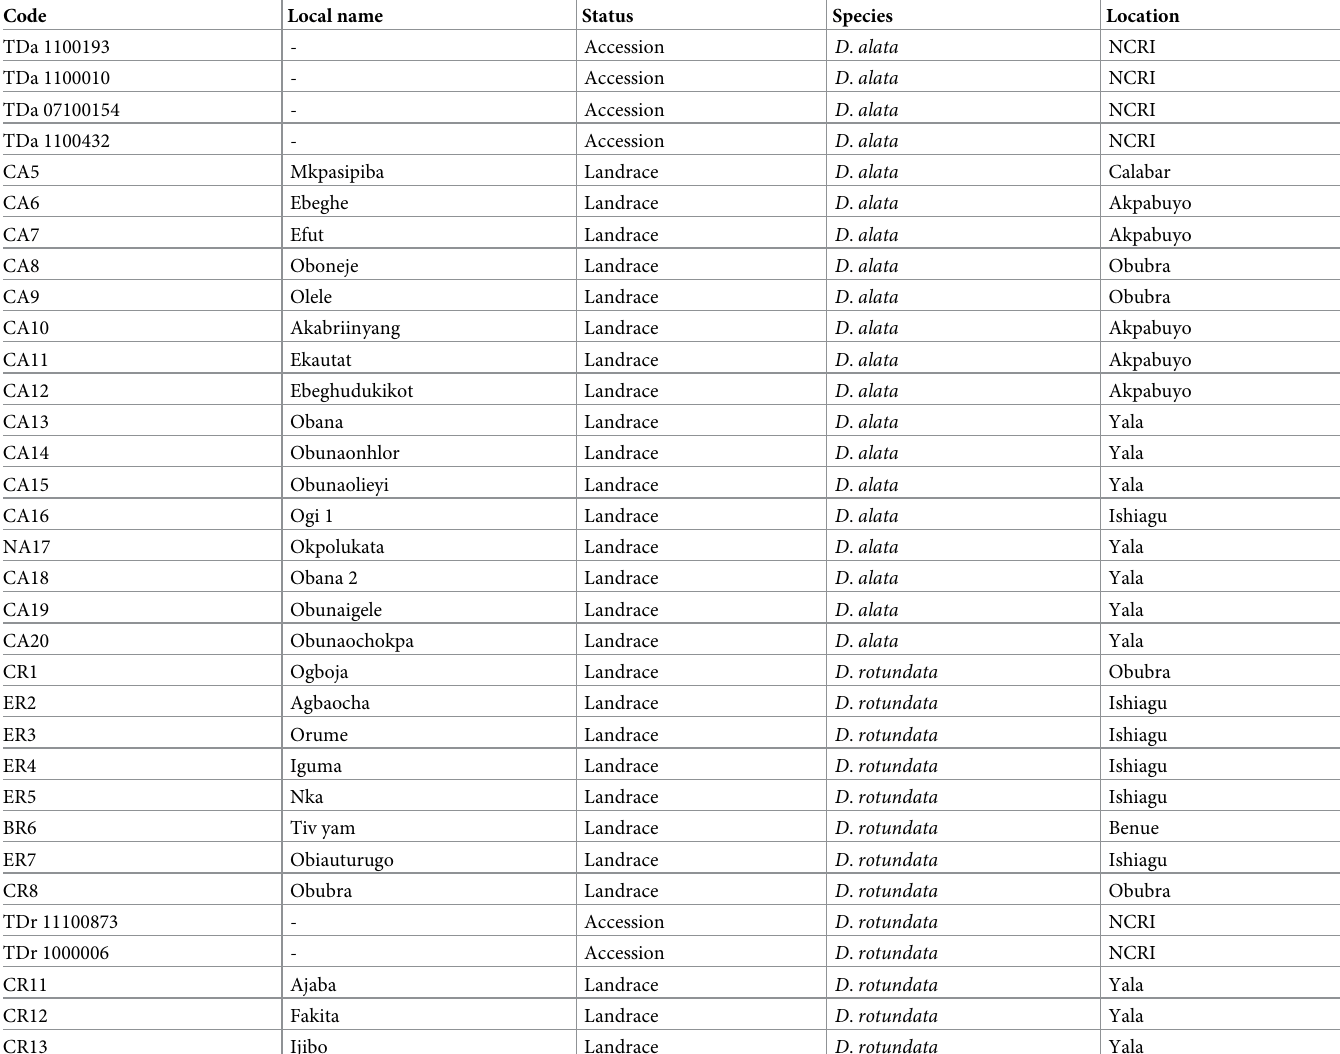
Table 2. Dioscorea alata and Dioscorea rotundata yam Accession/landraces and collection locations.